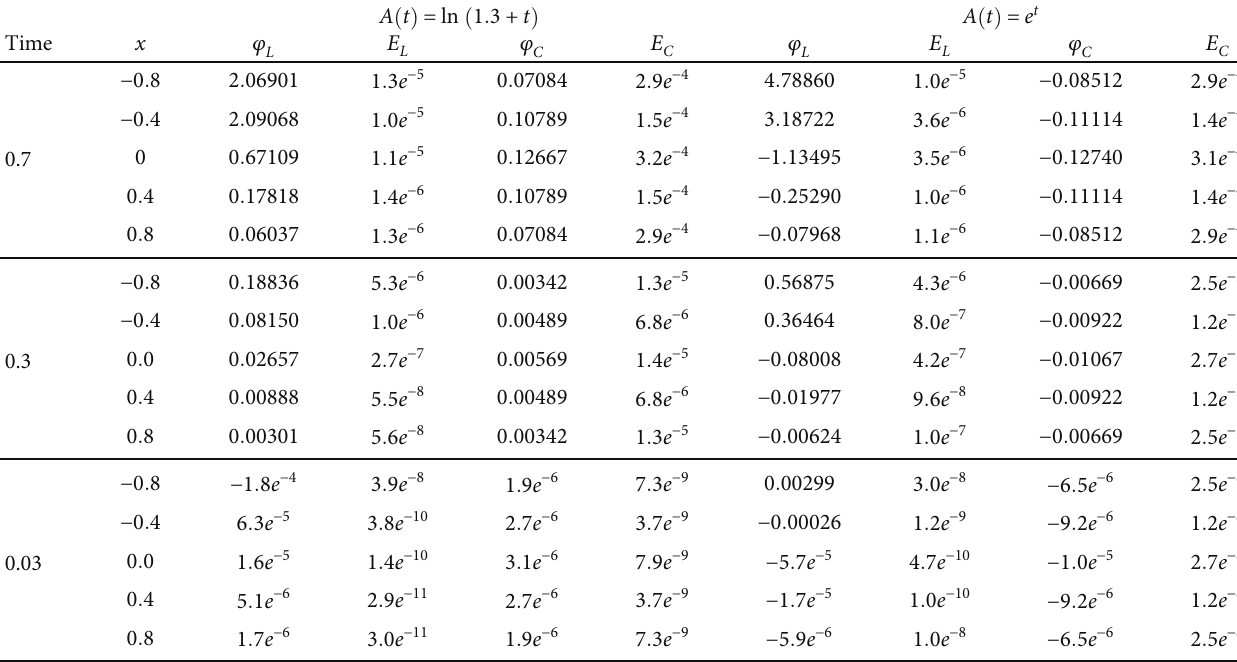
Table 1: N = 17, L ð x Þ = ð 1 + x Þ 3 .